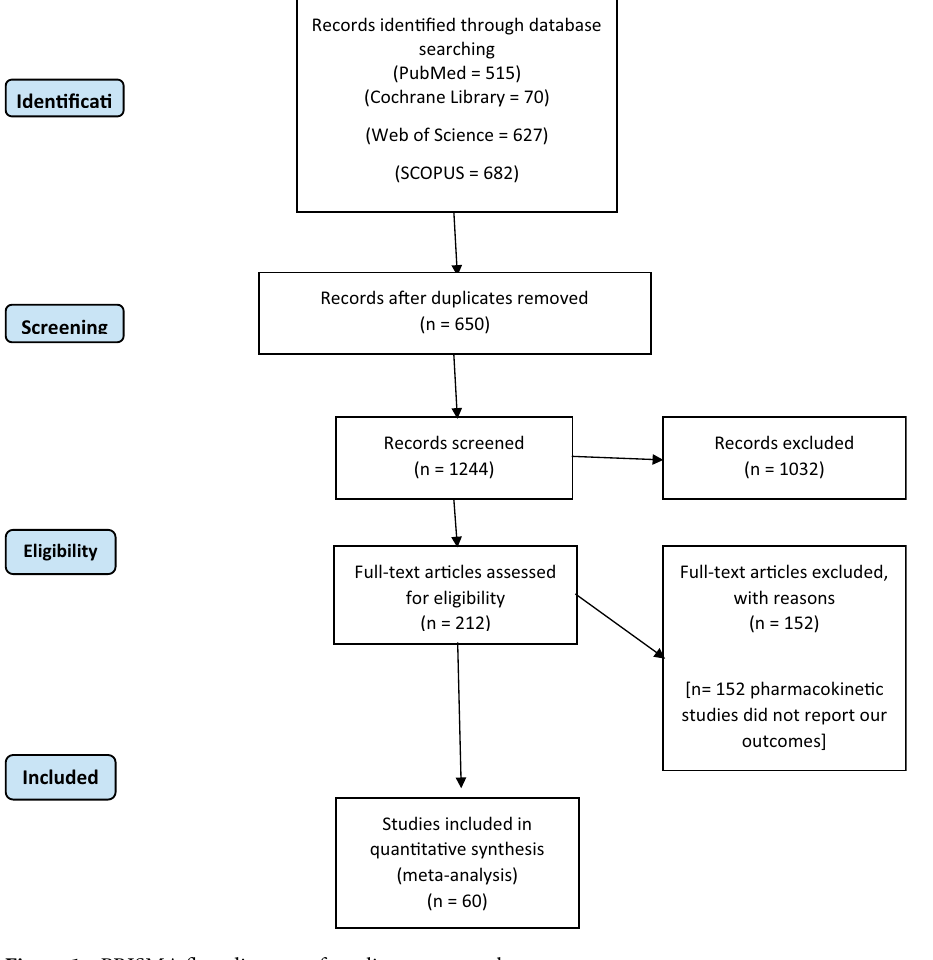
Figure 1. PRISMA flow diagram of our literature